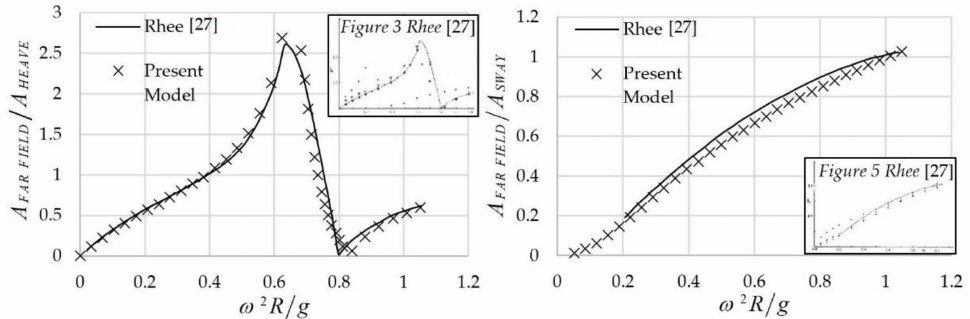
Figure 2. Amplitude ratios for heave and sway for a twin-hull floating structure with semicircle hull cross-sections ( 2 P / R = 3, h / R = ∞ )